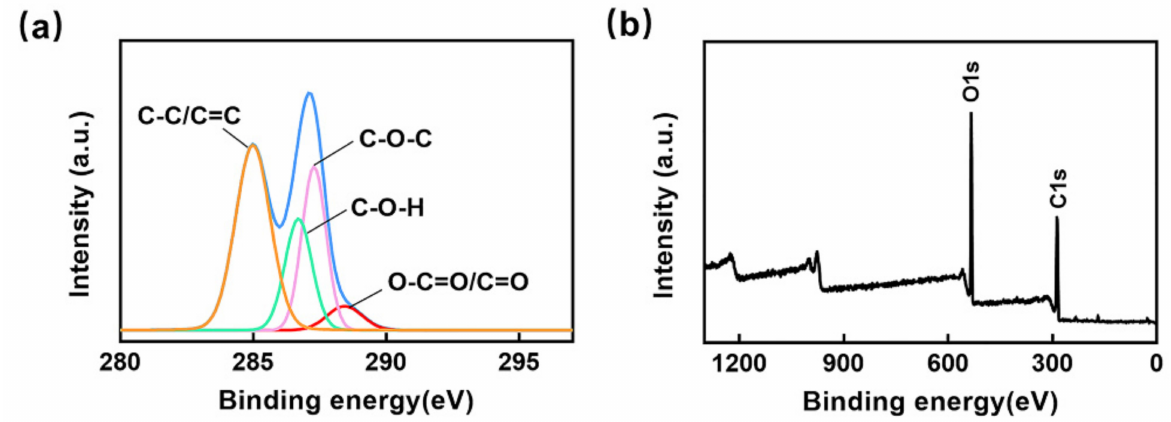
Figure 2. ( a ) XPS image of GO (C1s). ( b ) XPS image of GO (full